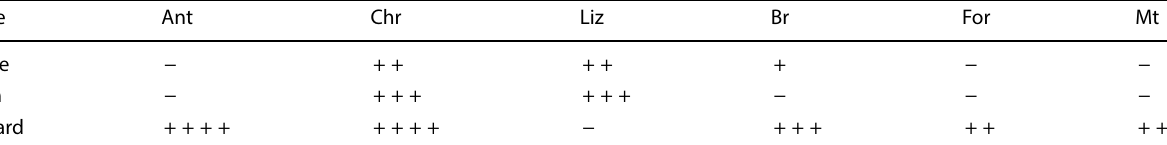
Table 1 XRD results (Ant: antigorite, Chr: chrysotile, Liz: lizardite, Br: brucite, 1 For: forsterite, Mt: magnesite, 2 + + + + : Very abundant, + + + : Abundant, + + : Moderate, + : Little, -: None) Sample